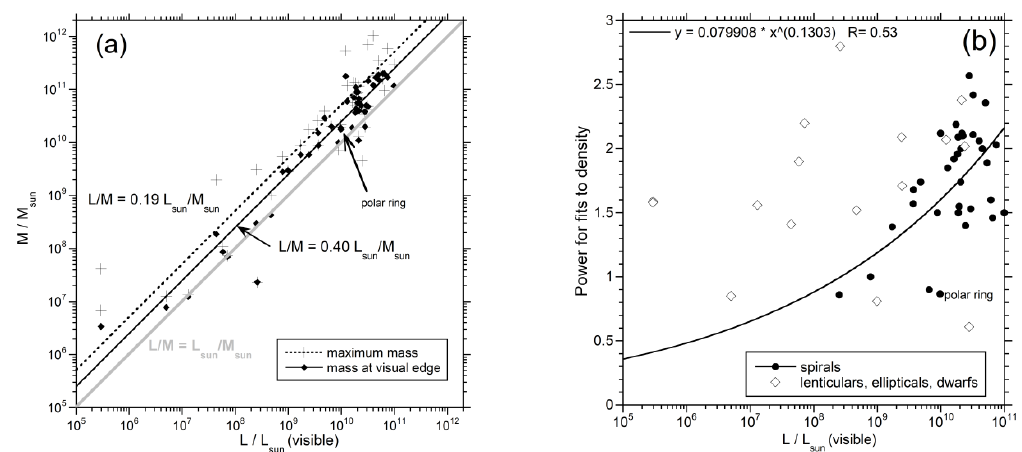
Figure 13. Dependence of calculated parameters on measured visible luminosity of our galaxy sample. Least squares fits are shown: ( a ) Mass of all galaxy types. The maximum mass is a ff ected by the termination of velocity measurements with distance. The visual edge provides a more consistent measure of galaxy size in relationship to luminosity. Power law fits give exponents very close to unity: the linear fits shown are similar. Grey line indicates a 1:1 correspondence; ( b ) Power ( − n ) for fits to density vs. radius. The least squares fit for spirals (solid curve) shows that density is more concentrated in the centers of larger galaxies. The polar-ring galaxy is less concentrated than normal spirals of similar size.